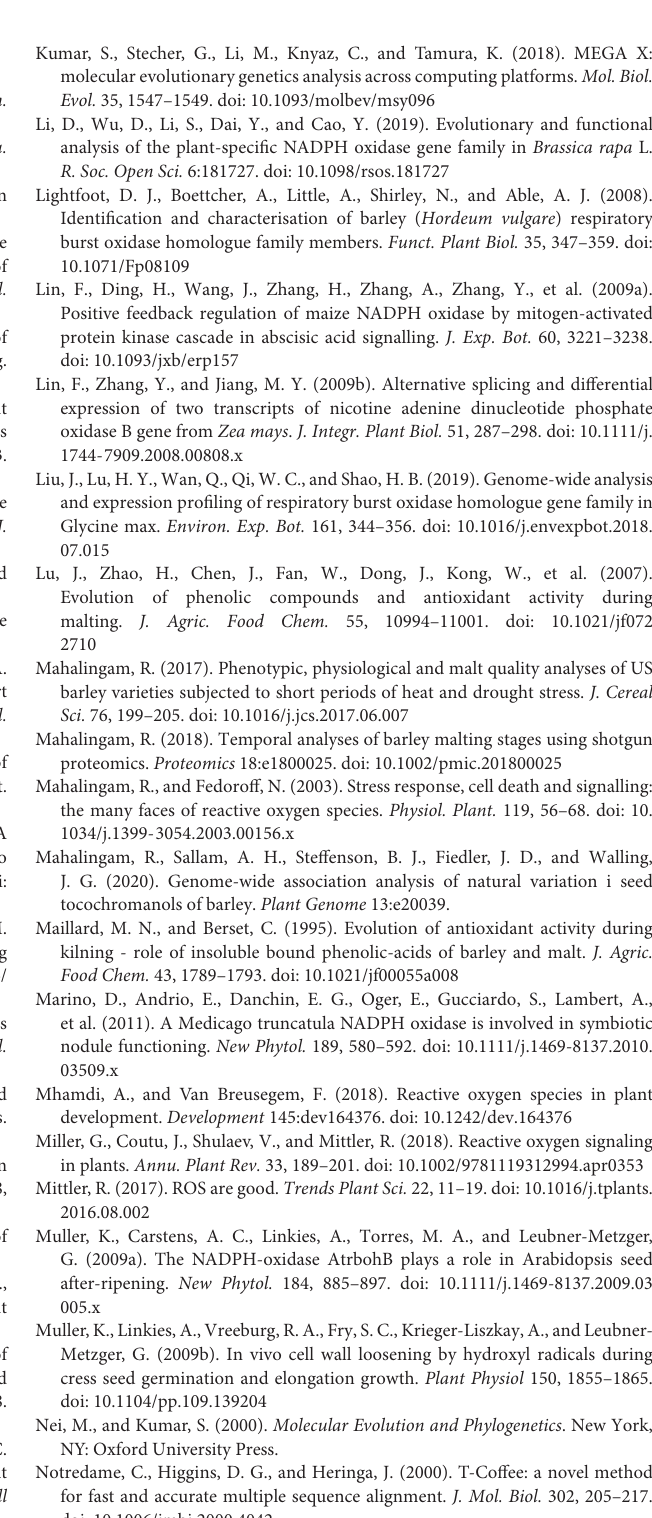
Supplementary Table 2 | Averaged cT values from the real-time PCR analysis of the HvRBOH genes during malting in barley variety Conrad, HvRBOHA/C knockdown line and wildtype Golden Promise.